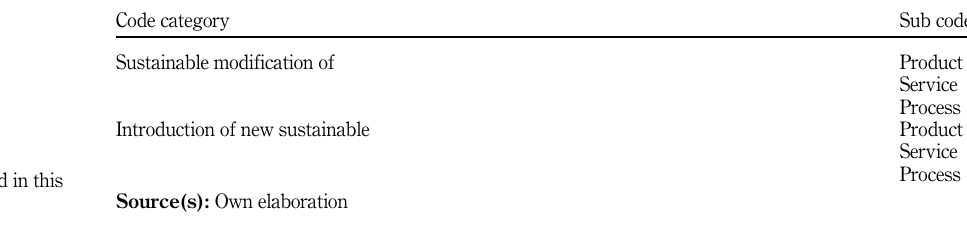
Table 2. Codes used in this